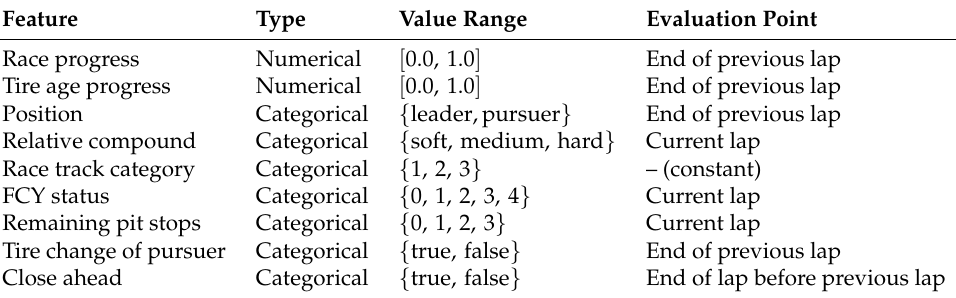
Table 5. Input feature set for a neural network to take the pit stop decision.